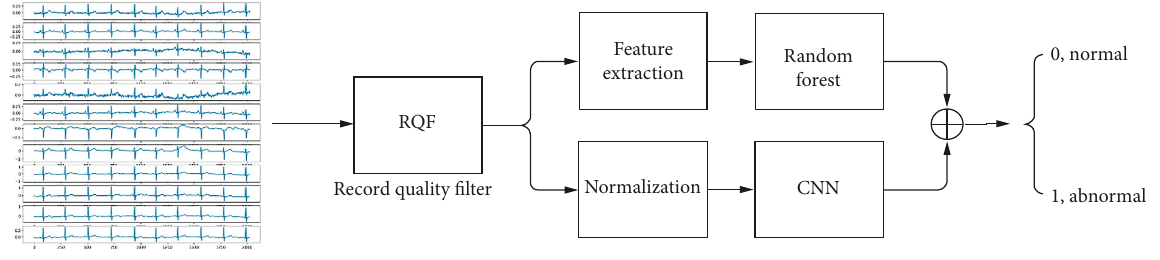
Figure 6: Model fusion architecture. Table 2: Summary of record classification performance on CCDD.